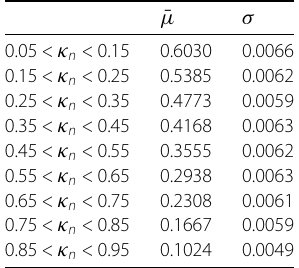
Figure 7 The histograms of the fraction of closed channels f c for the triangular unstructured network Table 3 The mean ¯ μ and the standard deviation σ of the distribution of f c for the triangular unstructured network